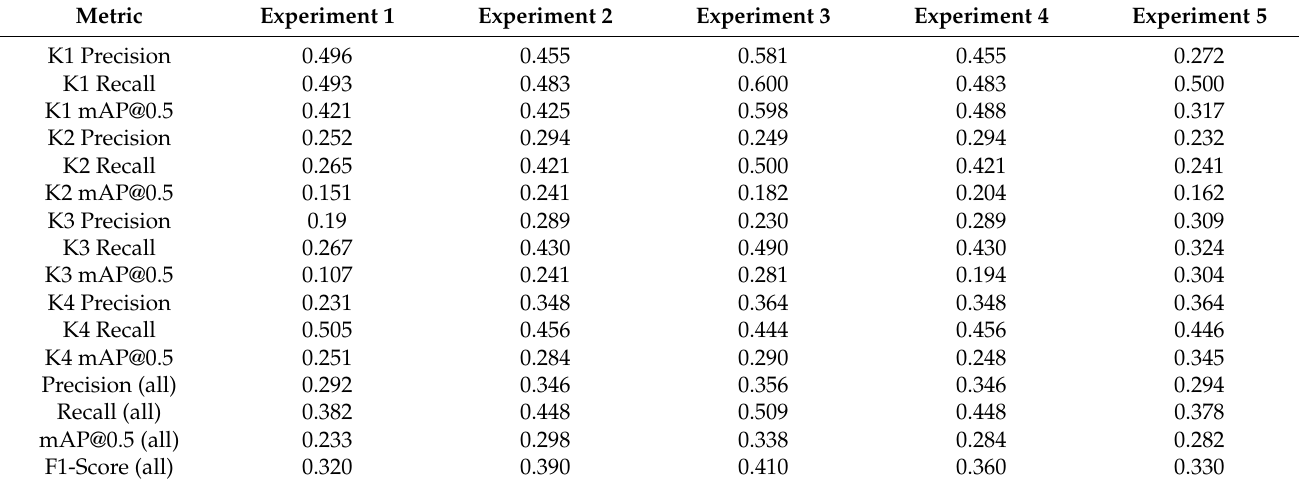
Table 5. Cross-validation results of a base